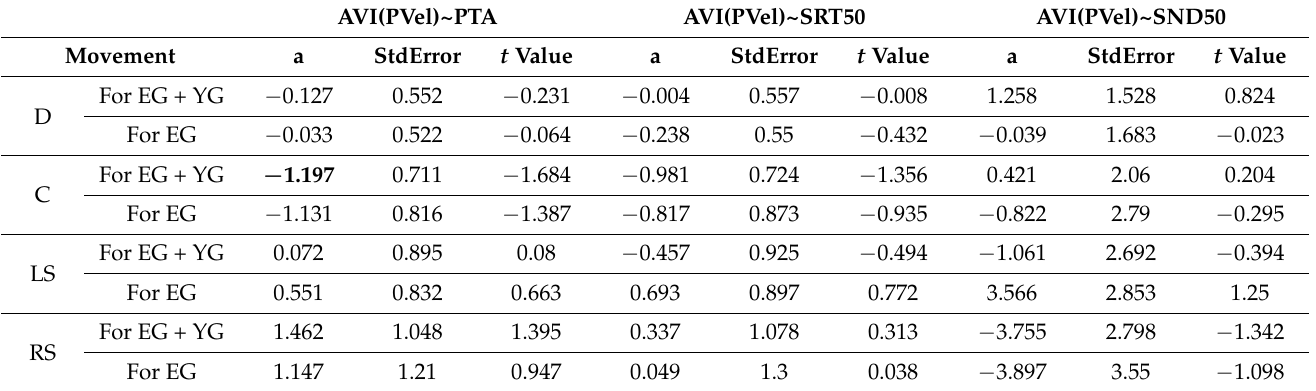
Table A1. Relations between AVI(PVel) and Hearing.